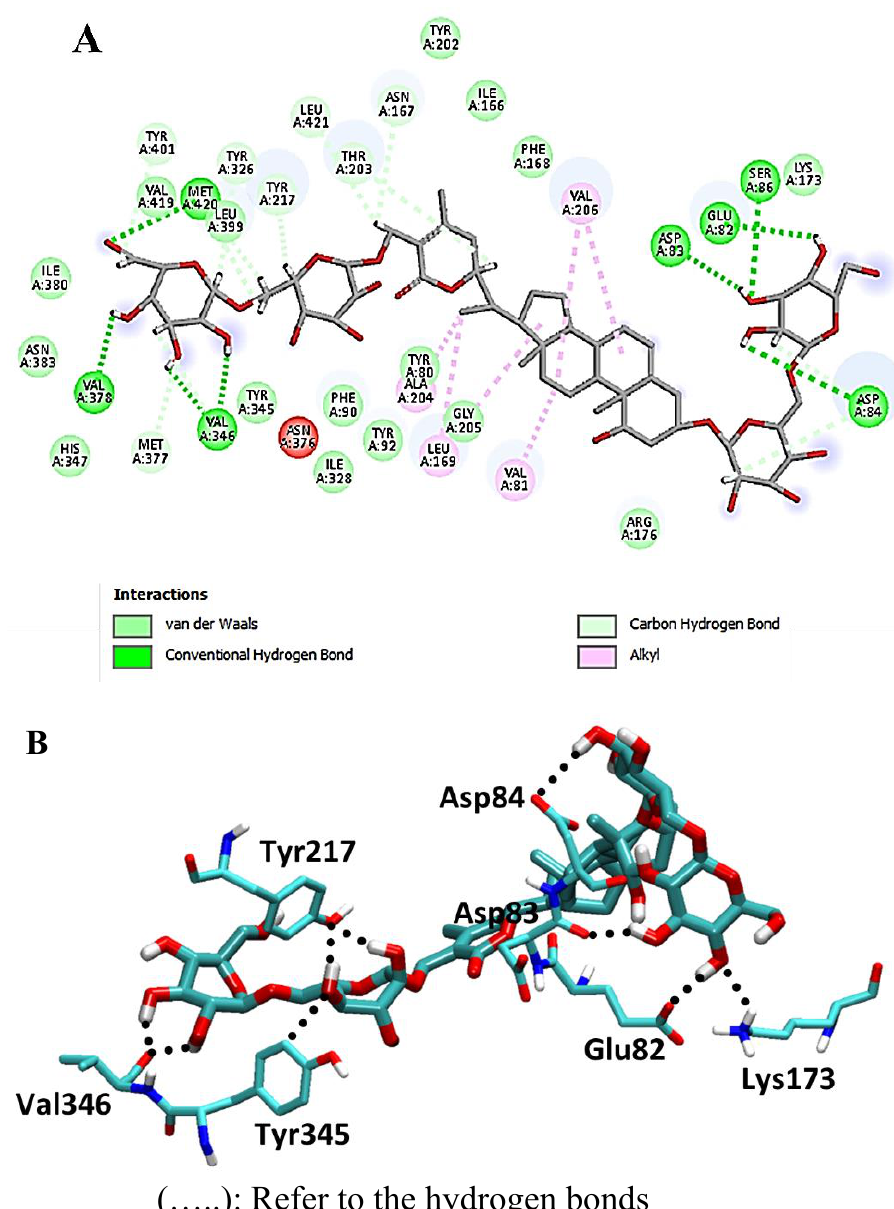
(…..): Refer to the hydrogen bonds Figure 7. 2D and 3D interaction complex of withanoside IX with NMT (( A ) and ( B ), respectively). Molecular-Dynamics Simulation